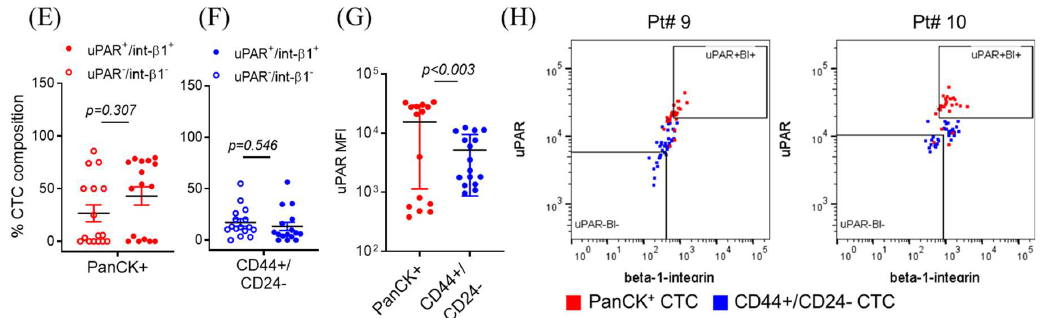
Figure 2. Stem-like (CD44 +/ CD24 − ) breast cancer CTCs are more likely to be mitotically inactive (Ki67 − ) than epithelial (PanCK + ) CTCs. ( A ) Distribution of Ki67 expression in epithelial and ( B ) stem-like CTCs across 16 patient samples. ( C ) Median fluorescence intensity (MFI) of Ki67 in CTCs. ( D ) Expression of Ki67 in epithelial and stem-like CTCs. Representative dot plots from patient #9 and #10 shown. ( E ) Combinatorial expression of uPAR and int-β1 in epithelial and ( F ) stem-like CTCs. ( G ) MFI of uPAR in CTCs. ( H ) Combinatorial expression of uPAR and int-β1in epithelial and stem-like CTCs. Representative dot plots from patient #9 and #10 are shown. Dot plots from all 16 patients are shown in Figure S1. CTCs from 16 metastatic breast cancer patients were used for these analyses. P-values were calculated using paired-t tests.